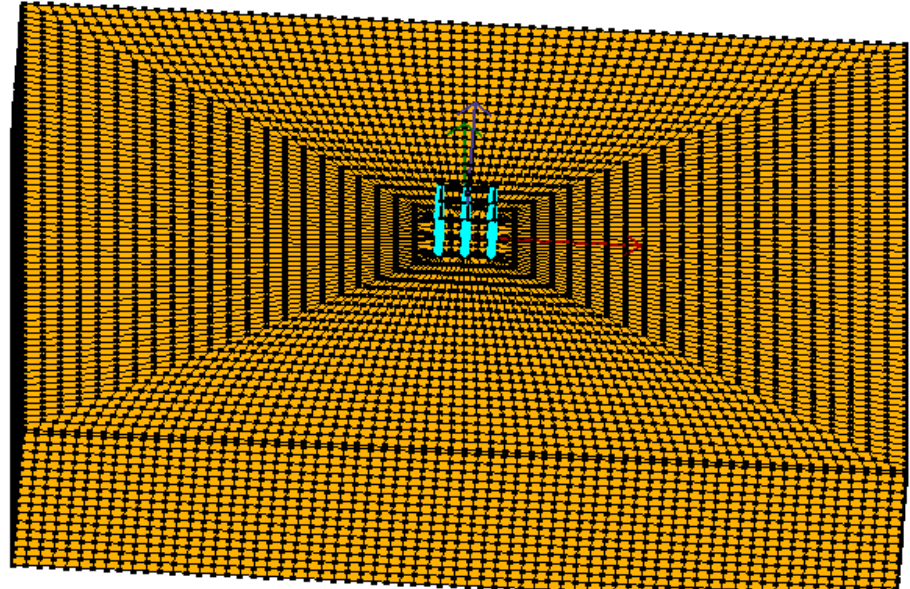
Figure 2. Three-dimensional (3D) mesh (Model 1).